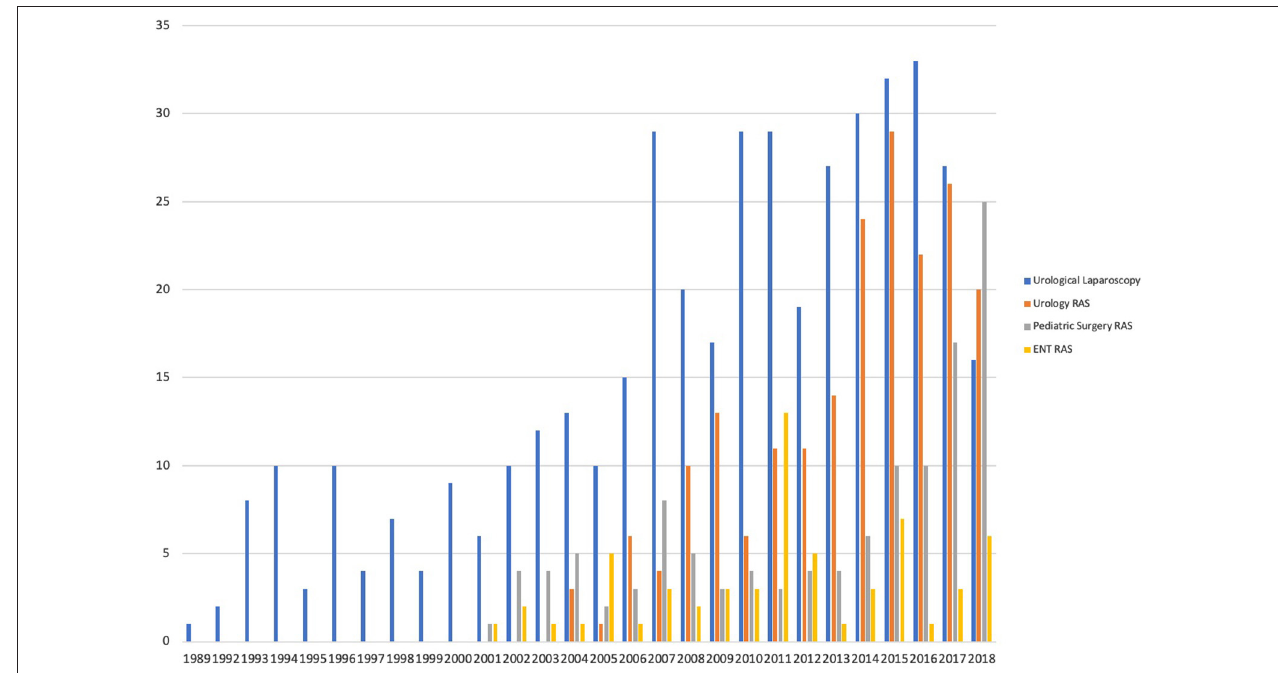
FIGURE 2 | Historical count of publications for laparoscopic and robot-assisted